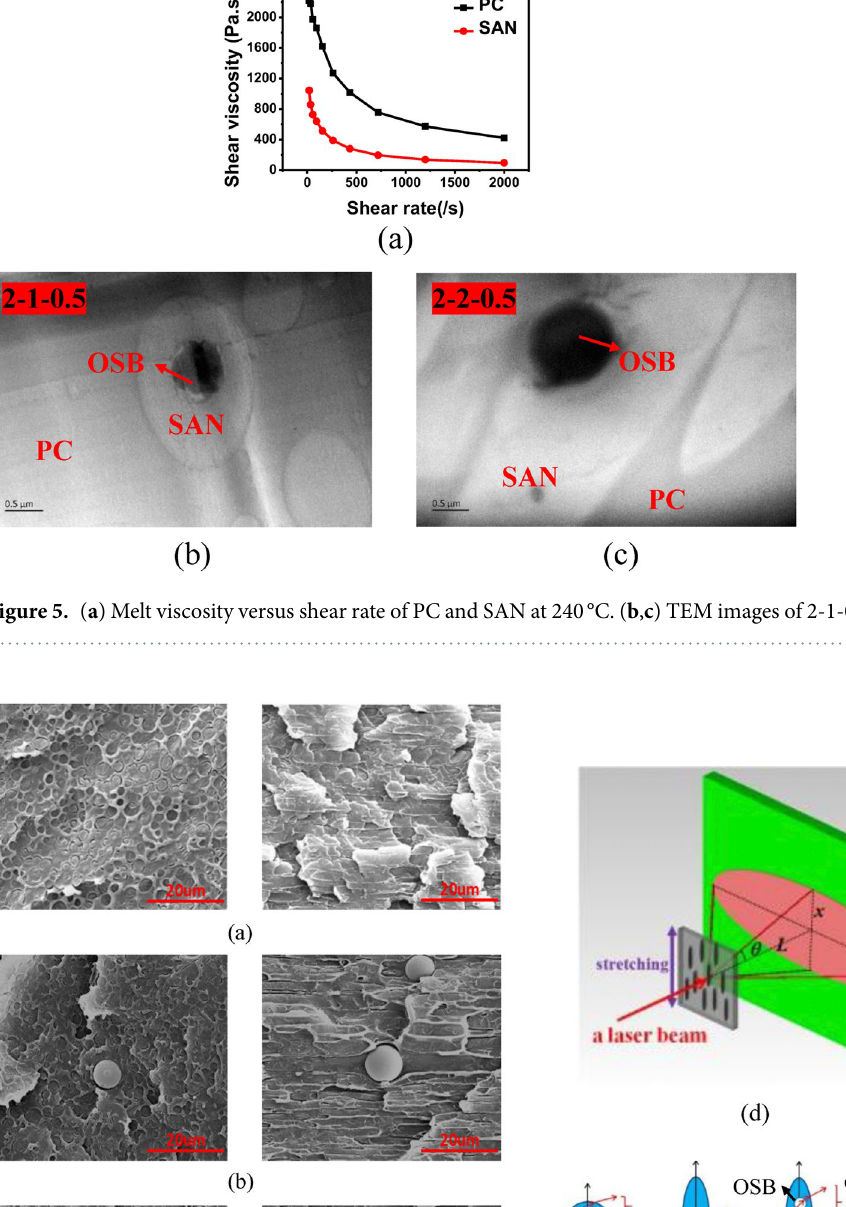
Therefore, the spherical SAN-OSB core-shell structure particles are deformed into spindle-shaped core-shell par- ticles. And as the draw ratio increases, the aspect ratio of the SAN phase gradually increases. Figure 6(a–c) are horizontal and vertical SEM images of PC/SAN, PC/SAN-OSB1, PC/SAN-OSB2 samples after hot drawing. When